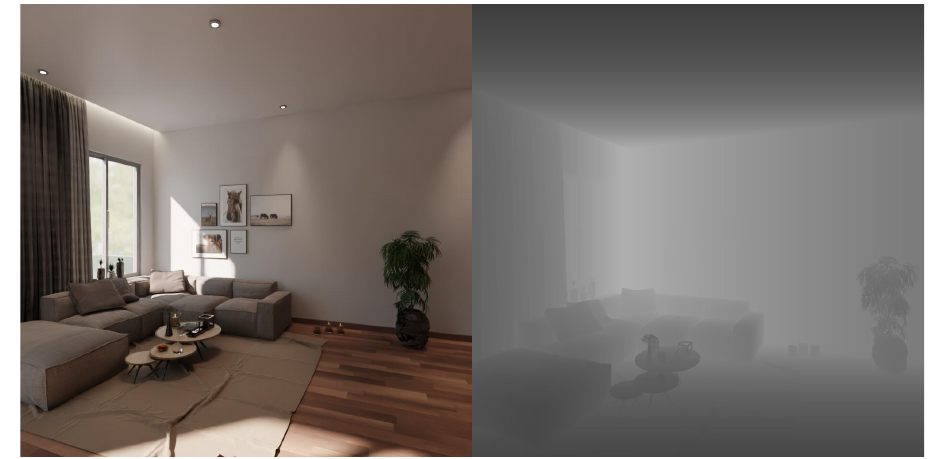
Figure 4. Our light field image and depth ground truth rendered by